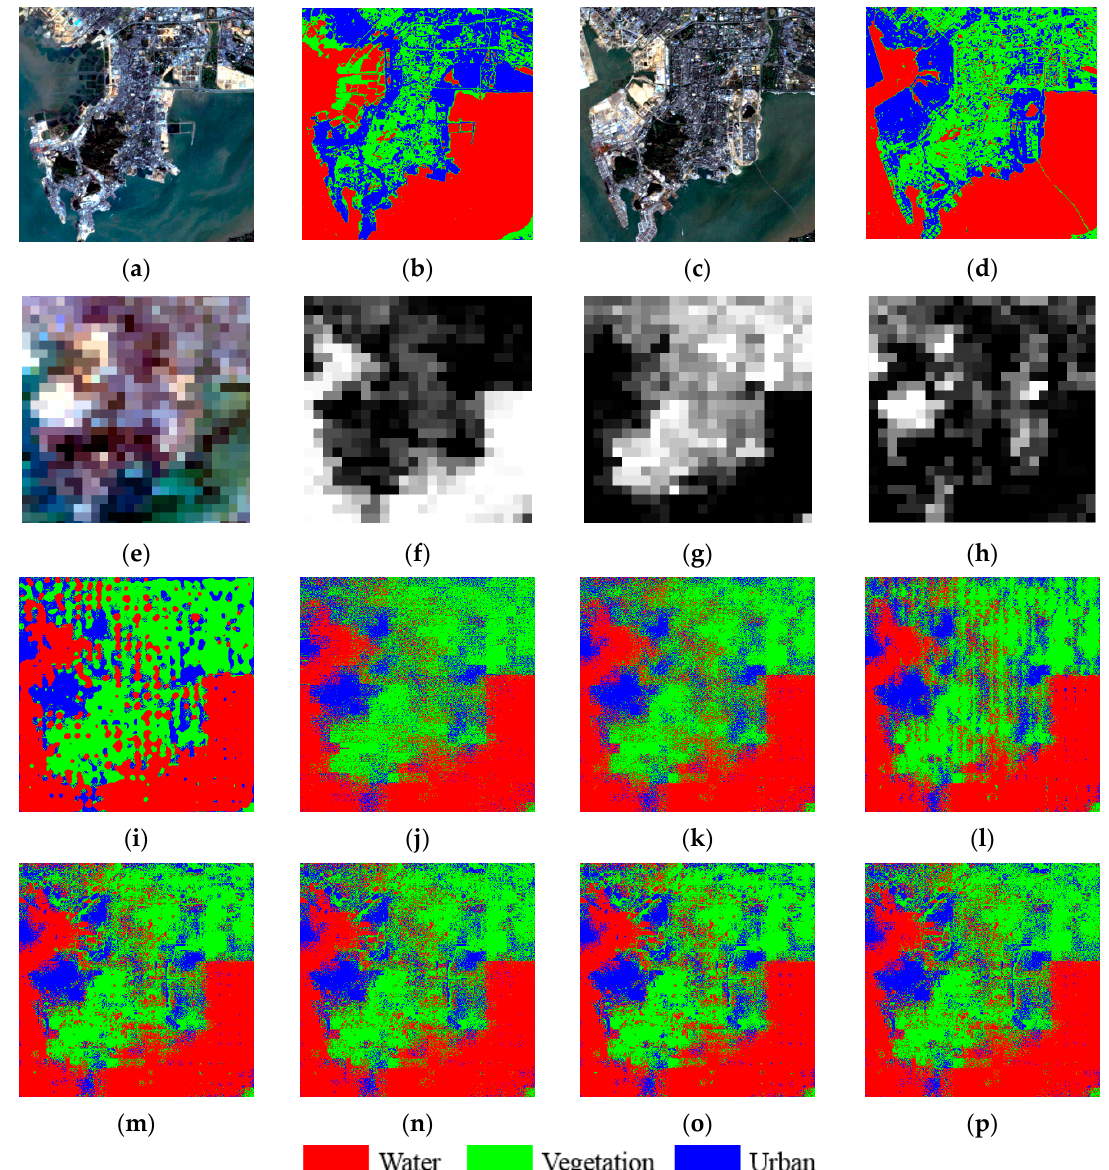
Figure 14. Sub-pixel mapping results for the 2009 MODIS image in Experiment 3: ( a ) Original TM image from 2001 (bands 4, 3, 2) (408 × 408); ( b ) K-Means classification result of the 2001 TM image (408 × 408); ( c ) Original TM image from 2009 (bands 4, 3, 2) (408 × 408); ( d ) K-Means classification result of the 2009 TM image (408 × 408); ( e ) Original MODIS image from 2009 (bands 4, 1, 2) (24 × 24); ( f ) Fraction image of water (24 × 24); ( g ) Fraction image of vegetation (24 × 24); ( h ) Fraction image of urban (24 × 24); ( i ) PSSM; ( j ) GASM; ( k ) DESM; ( l ) CSSM; ( m ) SSMPS; ( n ) SSMGA; ( o ) SSMDE; and ( p ) SSMCS.